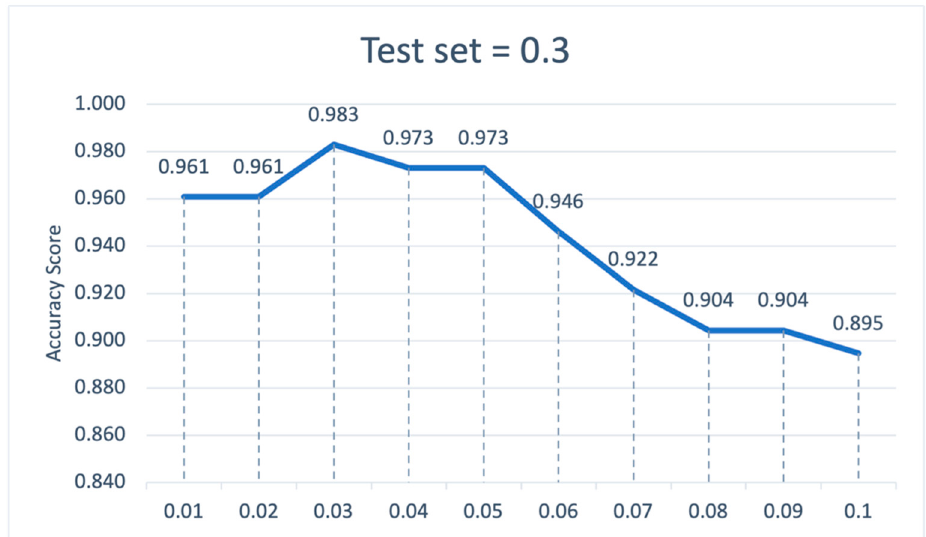
Figure 5. The model accuracy in different threshold level.